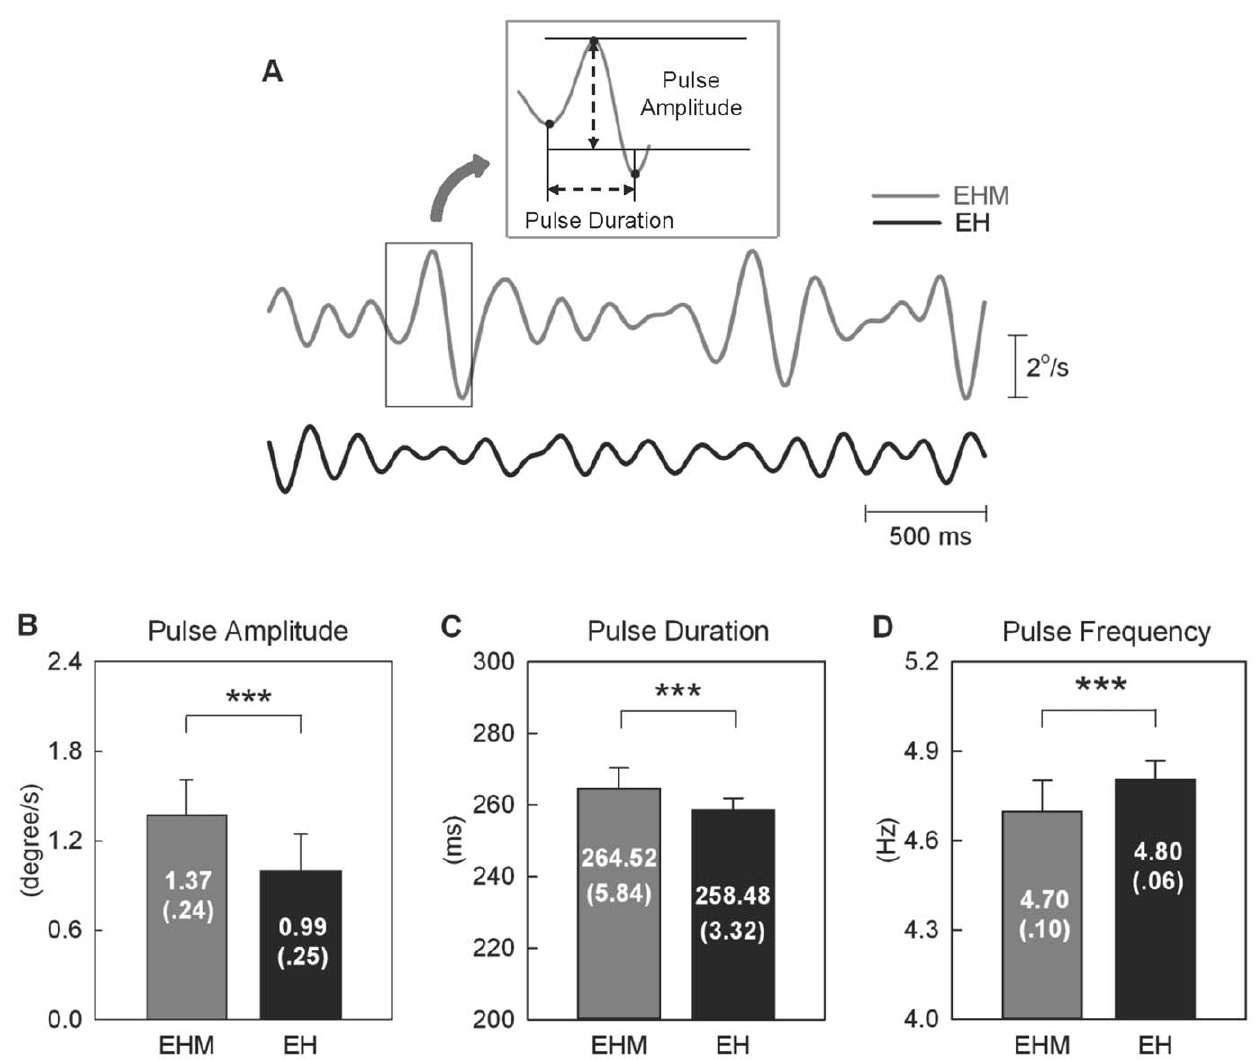
Figure 6. Contrasts of submovement characteristics between EH and EHM tracking. (A) Representative examples of speed pulse traces, with a box showing the measures of pulse amplitude and duration; (B) amplitude, (C) duration, (D) frequency of speed pulses (Significant difference, *** : P , 0.001).